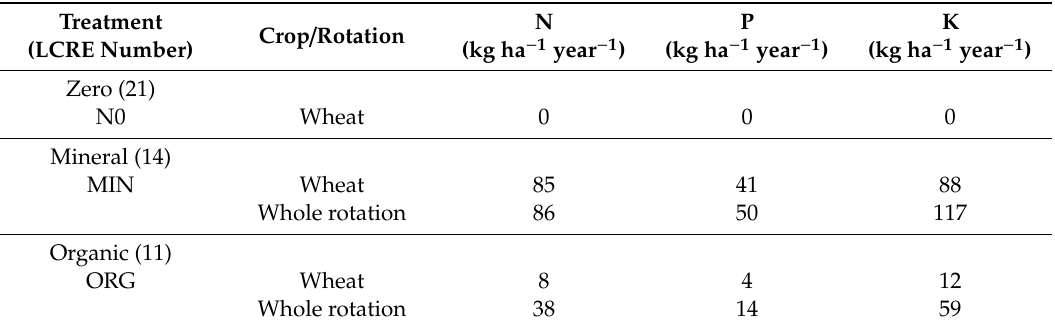
Table 1. Average inputs of N, P, and K in the mineral and organic fertilizers into the wheat and within the whole crop